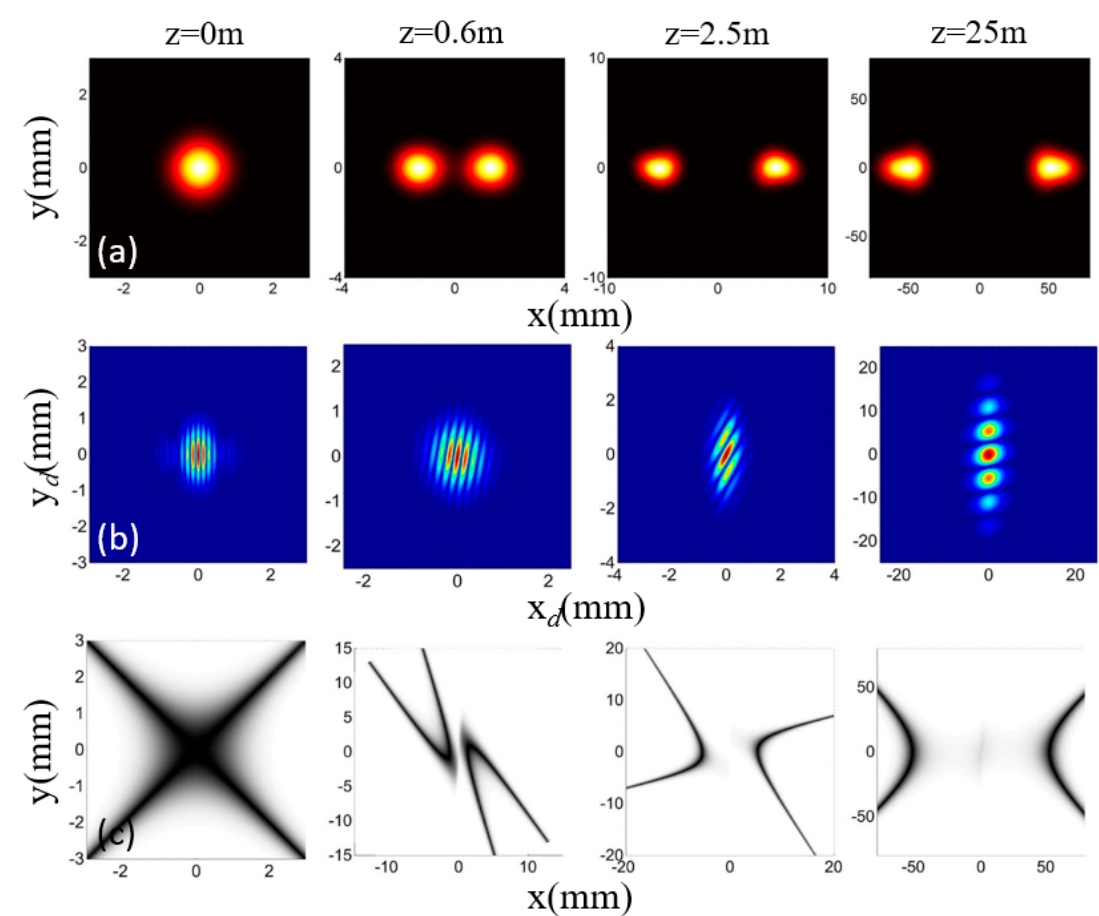
Figure 3. The ( a ) spectral density, ( b ) DOC and ( c ) degree of polarization (DOP) generated by an EM TGSMA source during propagation.